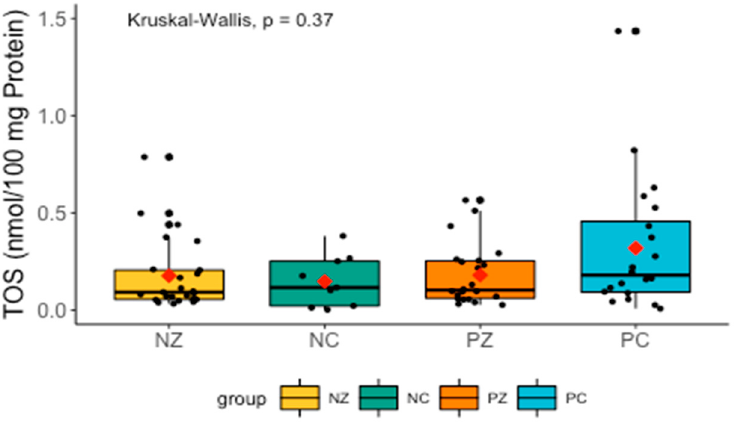
Figure 2. Levels of TOS in the saliva of the examined women. TOS, total oxidant status; NZ, generally